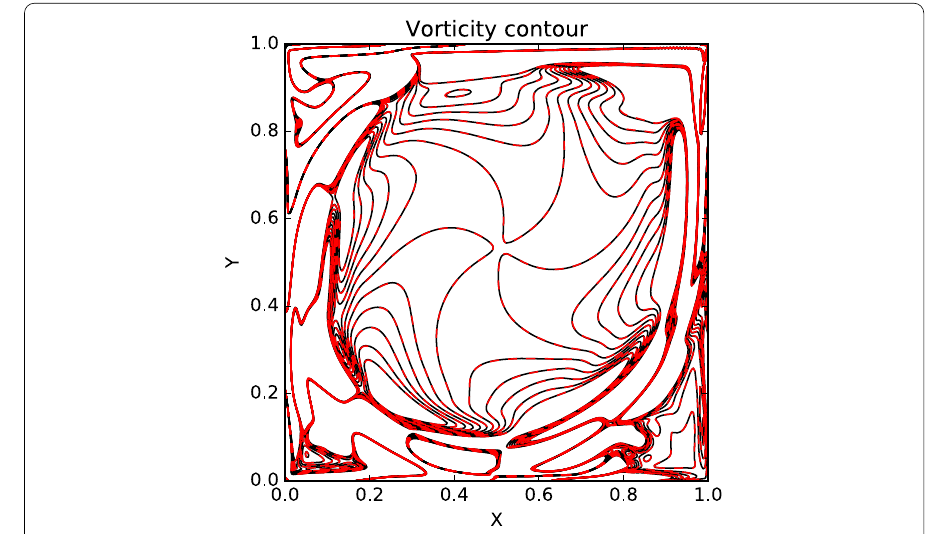
Fig. 7 Disturbance vorticity contour plot for reconstructed vorticity (solid lines) and DNS vorticity (dotted lines) field at nondimensional time t = 1900 . 199 for target Re = 10040 with donor points having Re = 10,000, 10,020, 10,060 and